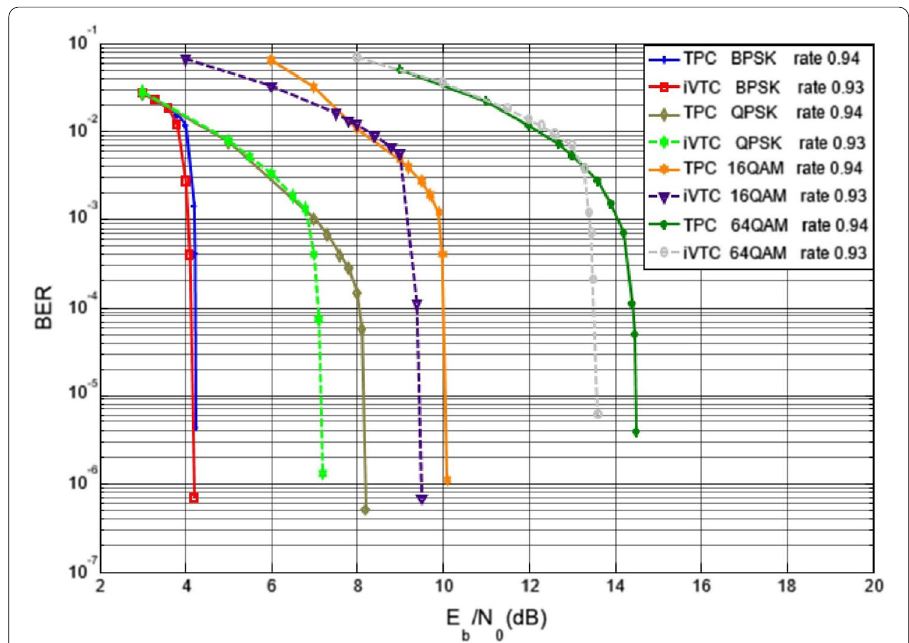
Fig. 6 (255, 247)TPC and equivalent iVTC BER versus E b / N 0 for BPSK, QPSK, 16QAM and